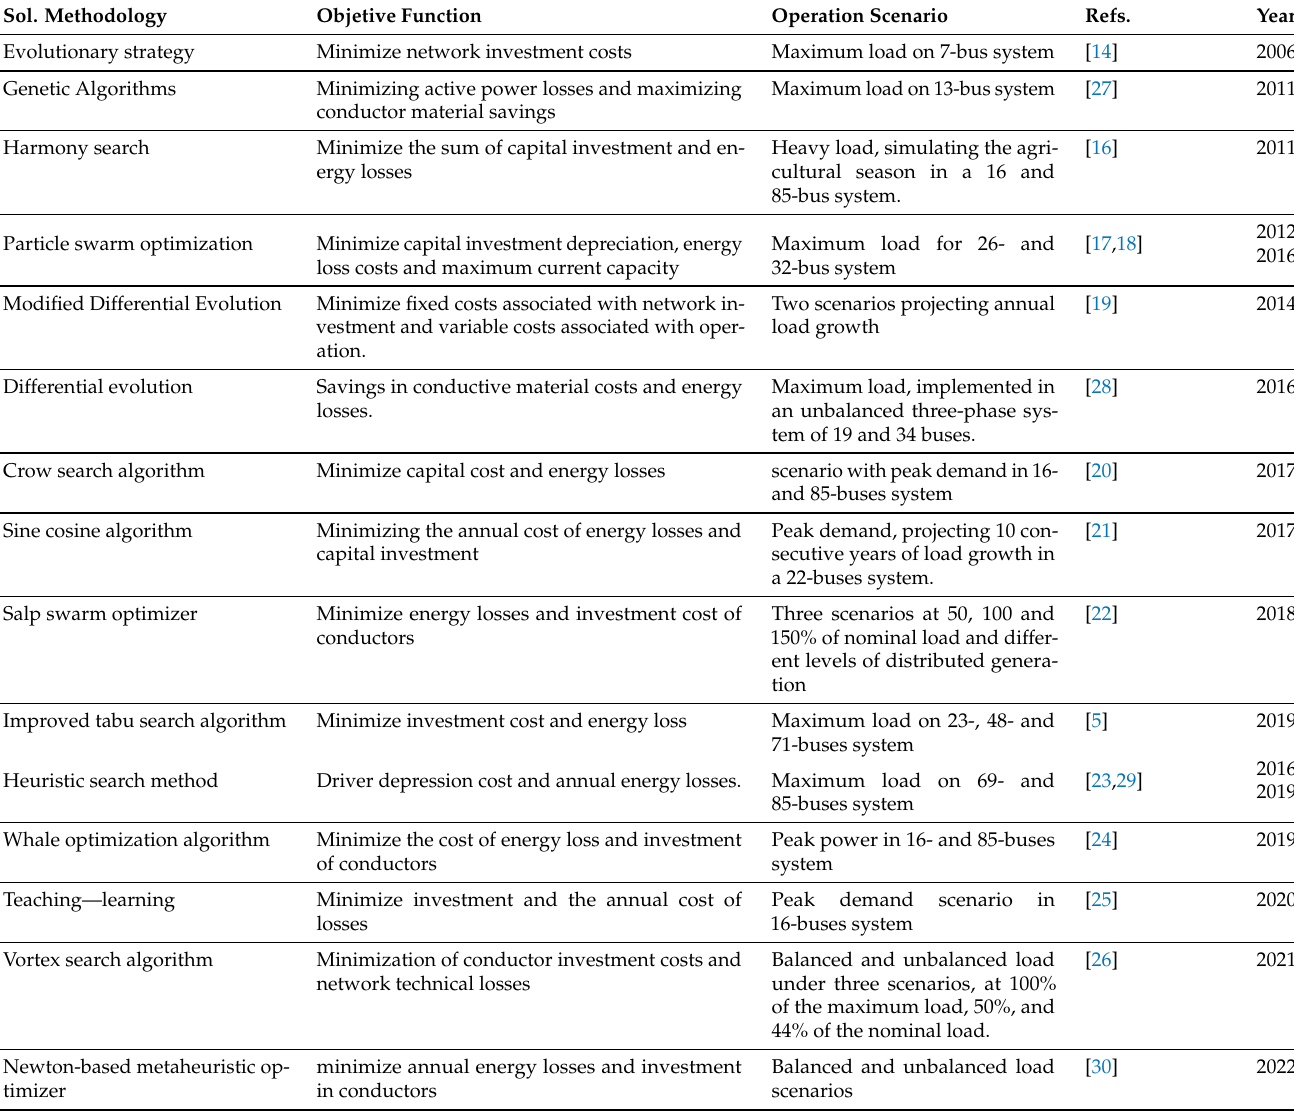
Table 1. Summary of the methodologies used in the literature for the problem of optimal conductor selection in distribution